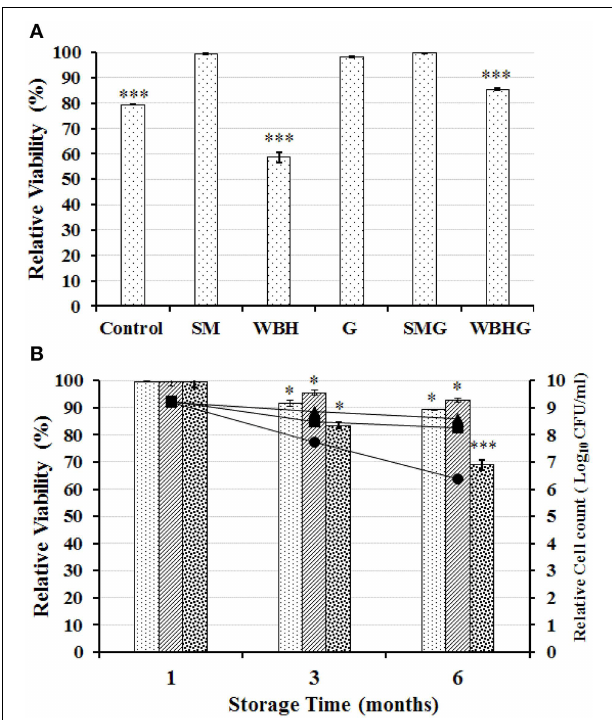
FIGURE 7 | Viability of strains KID7 under freeze-drying and storage conditions. (A) Viability of strain KID7 after freeze-drying with various combinations of food grade additives such as SM, skim milk (1%); G, galactomannan (1%); WBH, wheat bran hydrolysate (1%); SMG, skim milk (0.5%) + galactomannan (0.5%); WBHG, wheat bran hydrolysate (0.5%) + galactomannan (0.5%); and Control, KID7 cells in PBS without food grade additives. (B) Viability of strain KID7 combined with SMG, skim milk (0.5 %) + galactomannan (0.5%) under different storage conditions such as − 20 ◦ C ( , (cid:4) ), 4 ◦ C ( , N ), and 25 ◦ C ( , • ), up to 6 months. Histogram represents percentage viability of KID7 under different storage condition. Line graph represents relative logarithmic value of colony-forming units of KID7 under different storage condition. Error bars represent standard error of mean of three independent experiments. * P < 0 . 05 and *** P < 0 . 005 significantly different at the P -values compared to initial